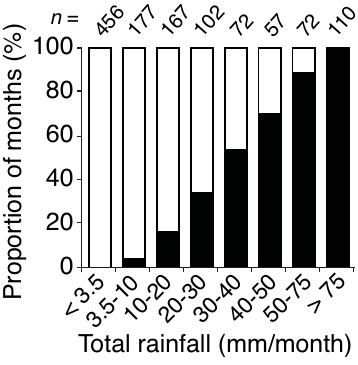
Figure 4. Total monthly rainfall in the upper Fortescue River catch- ment causing an increase in surface water area measured as the pro- portion of months with net change in flood area or (cid:49)F A > 0km 2 (black columns) at the Fortescue Marsh (1912–2012).